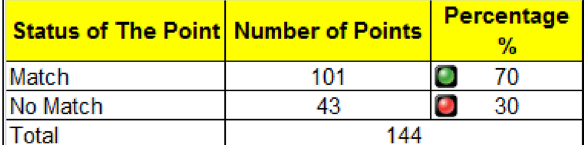
Table 6 Expert system validated points status